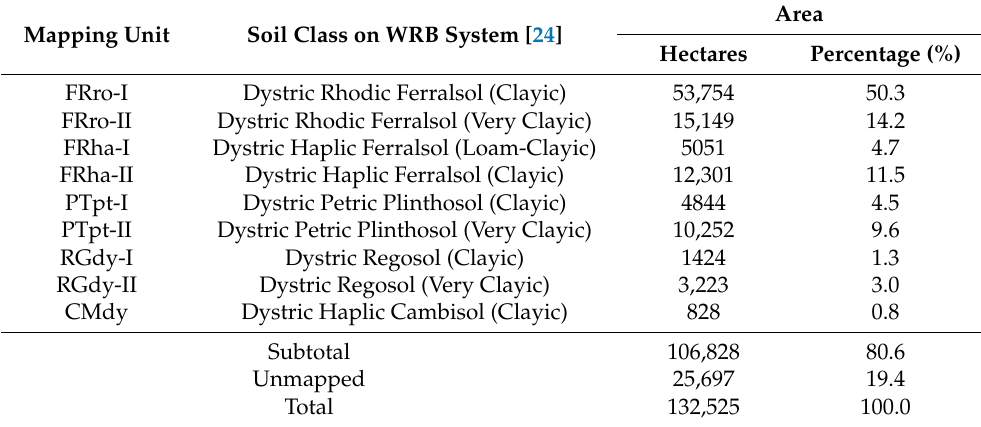
Table 5. Accounting for mapped and unmapped areas. WRB: World Reference Base [24].